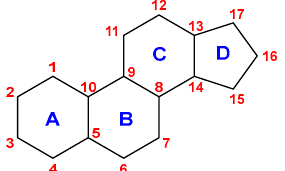
Figure 2. The structure of steroid nucleus.